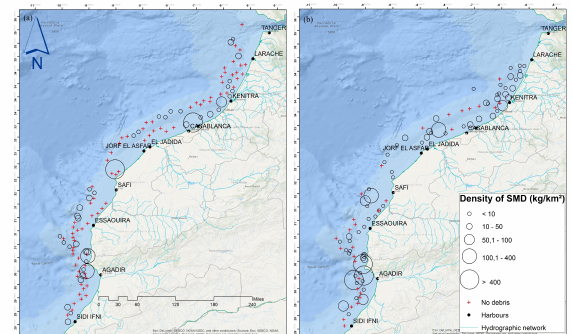
Figure 5. The spatial distribution of SMD between Tangier and Sidi Ifni during the both prospection surveys on board of the charif Al Idrissi vessel.(a) in 2015,(b ) in 2018.